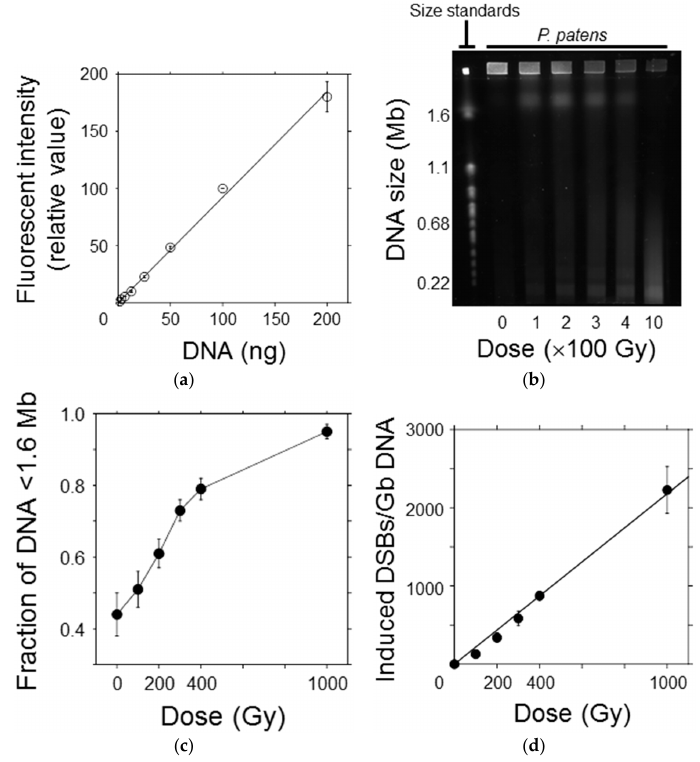
Figure 4. Initial yield of DNA double-strand breaks (DSBs) in P. patens protoplasts after γ -irradiation. ( a ) The relationship between DNA quantity and fluorescence intensity of SYBR Green I was almost linear, indicating that DNA fragments could be quantitatively detected in this range. ( b ) A representative image showing the DNA migration pattern in the electrophoresis gel. Chromosomal DNA of Saccaromyces cerevisiae was used as the molecular size standard. Chromosomal DNA of the protoplasts was reduced in size with increasing γ -ray dose. ( c ) The fraction of DNA fragments smaller than the exclusion size of 1.6 Mb increased in a dose-dependent manner. ( d ) Number of DSBs induced per Gb DNA plotted as a function of γ -ray dose. The number of DSBs increased linearly with increasing γ -ray dose. The initial DSB yield per Gb DNA per Gy was estimated to be 2.2 from the slope of the regression line.